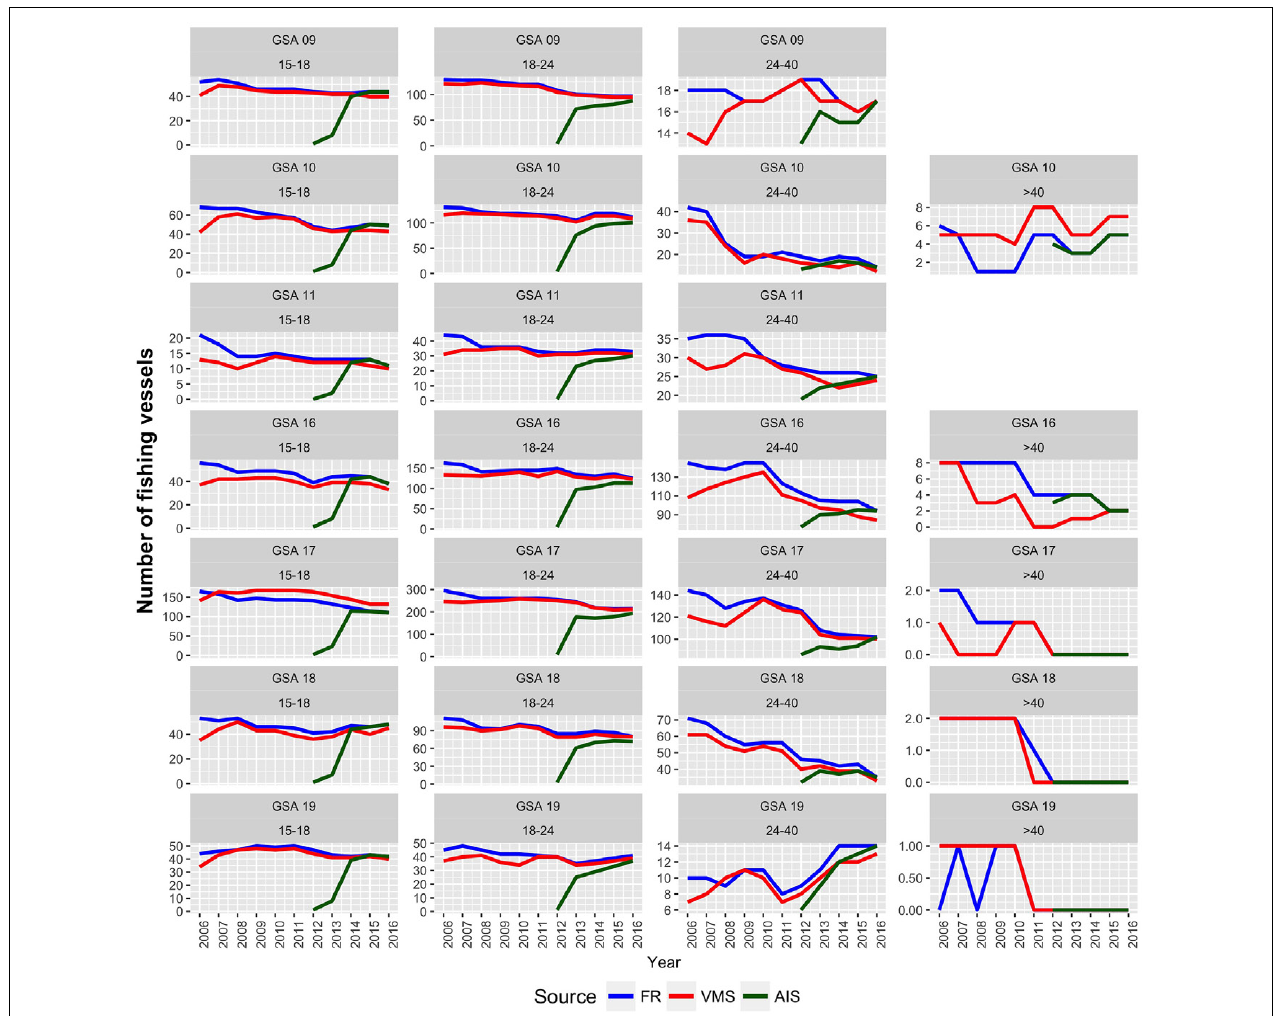
FIGURE 1 | Coverage of VMS and AIS, by year/GSA and length segment, with respect to the official data downloaded from the Community Fishing Fleet Register